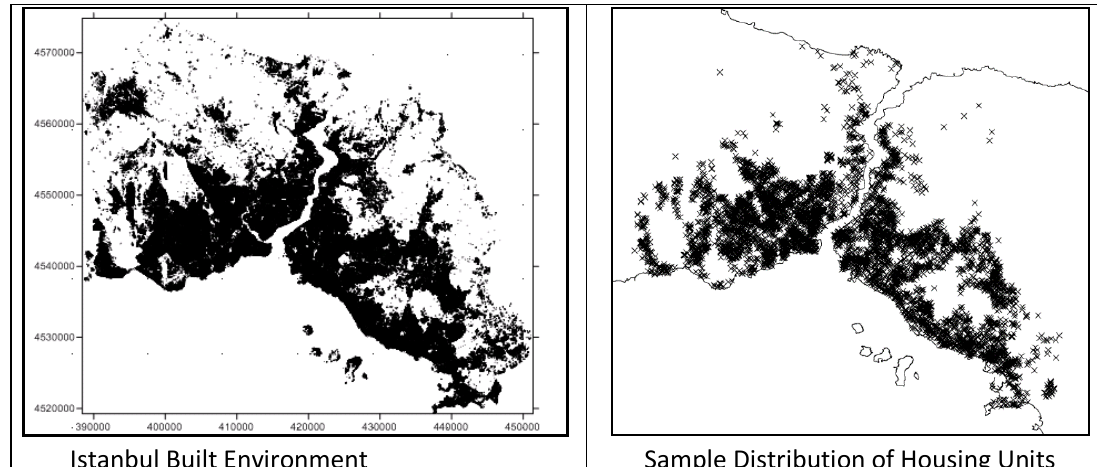
Sample Distribution of Housing Units Figure 1 Housing Units and Sampling